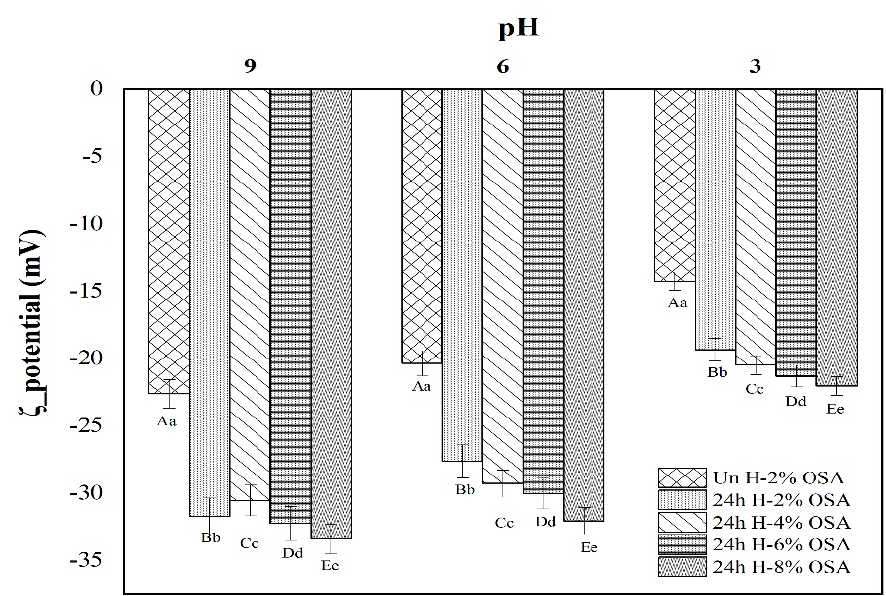
Figure 7. ζ -potential of fresh emulsions stabilized by high-amylose PMS (Kudzu) starch with differ- ent OSA concentrations. The significant difference of the same indicator is indicated with different letters in different samples ( p < 0.05).